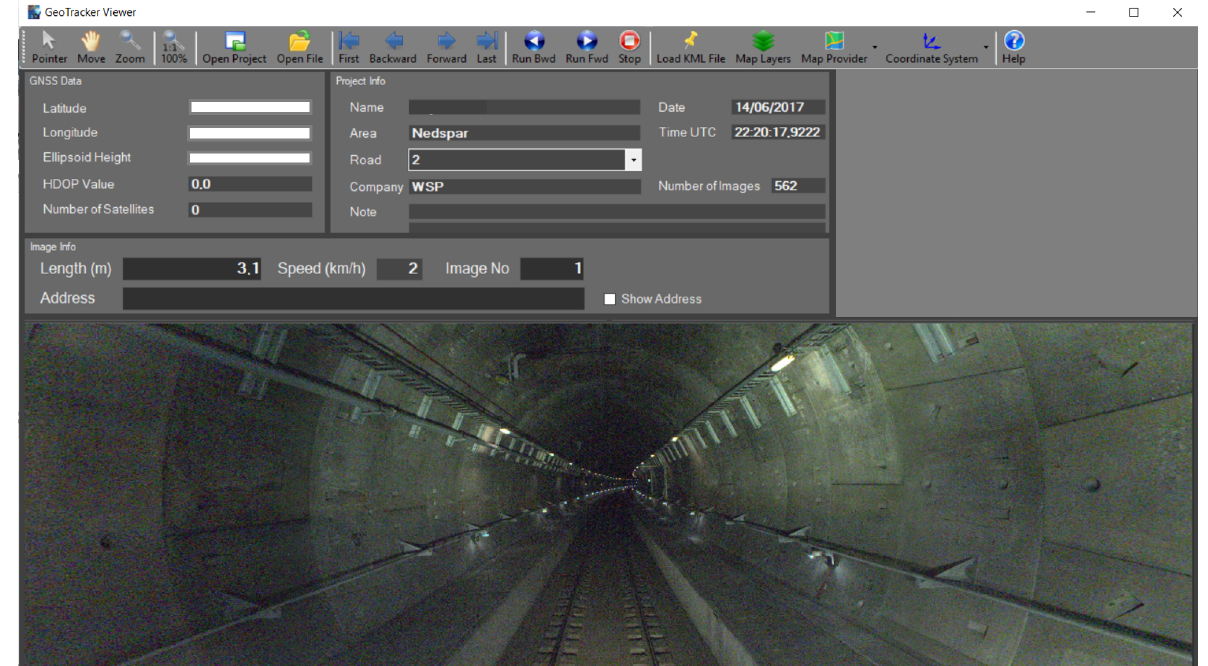
Figure 8. Geotracker software interface used by the company